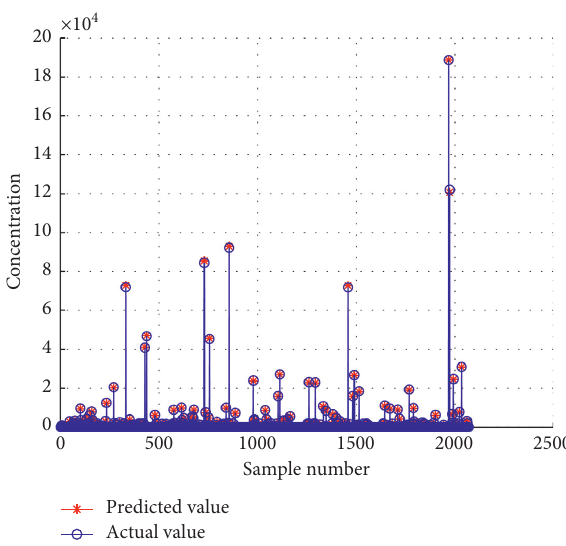
Figure 10: The fitting effect diagram of the Jining training set data.